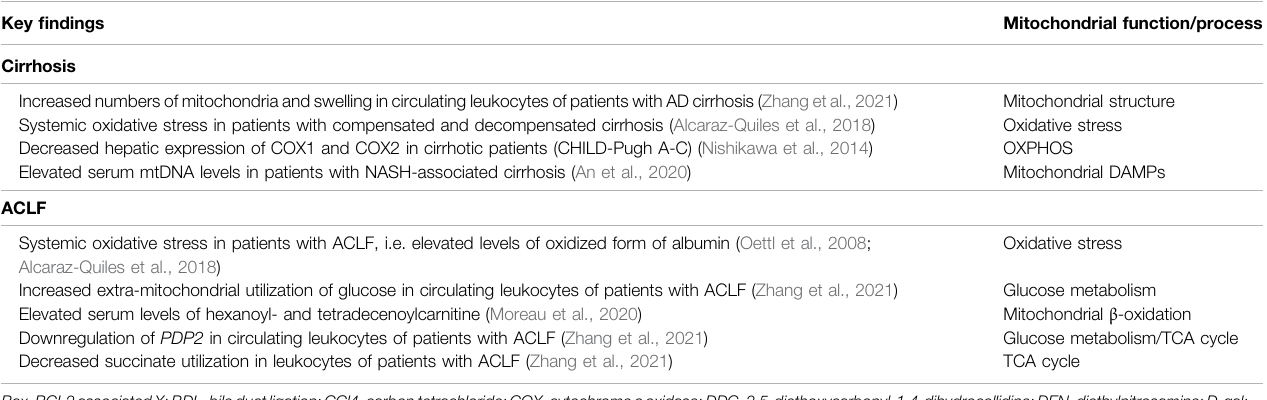
TABLE 1 | Overview of key fi ndings related to mitochondrial dysfunction in patients with cirrhosis and ACLF. Key fi